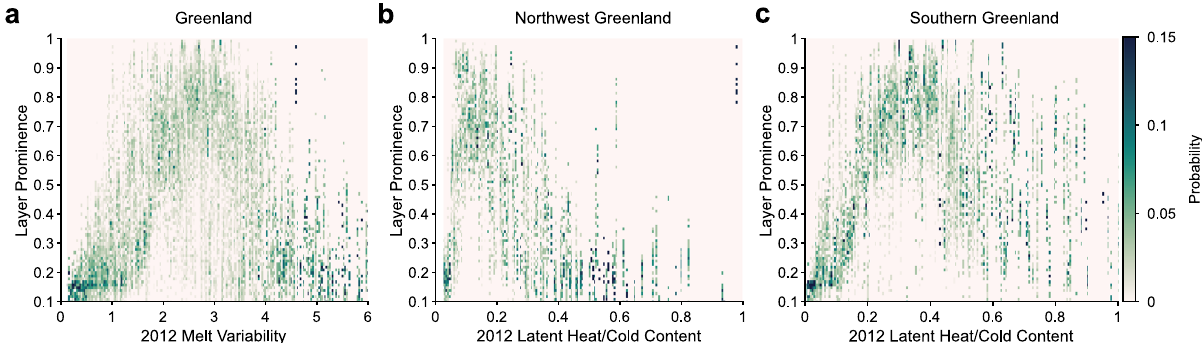
Fig. 3 Two-dimensional histograms showing the probability of a given layer prominence occurring for a given climate condition. Darker greens indicated higher probabilities. Greenland regions are de fi ned by the dashed boxes in Fig. 2c. a Correlation with the standard deviation of the modeled daily surface-melt production from January 1, 2012 to December 1, 2012 (see “ Methods ” section). b Correlation with the ratio of latent heat in the